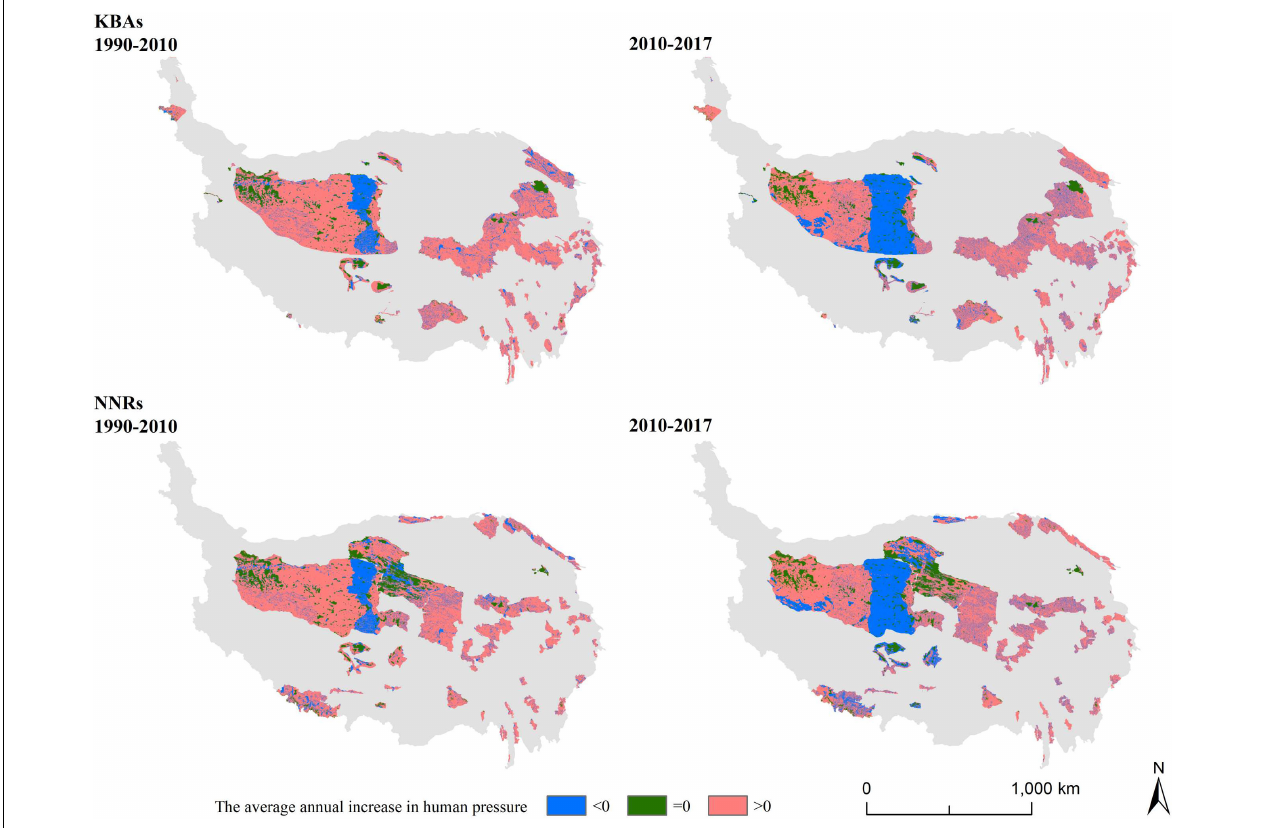
FIGURE 7 | Average annual increase in human